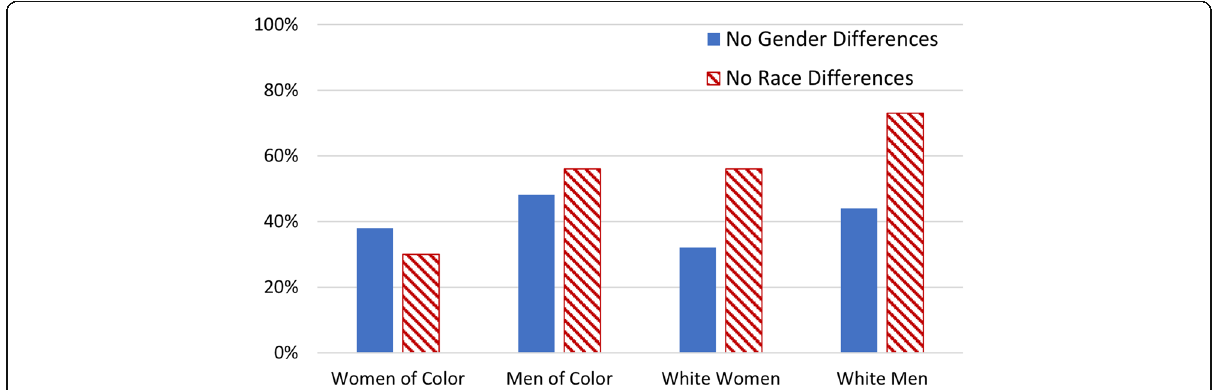
Fig. 2 Percent of respondents who did not notice gender differences by demographic group and percent of respondents who did not notice race differences by demographic group. Percentages are calculated using the total number of respondents (see Table 2) in each group from our data